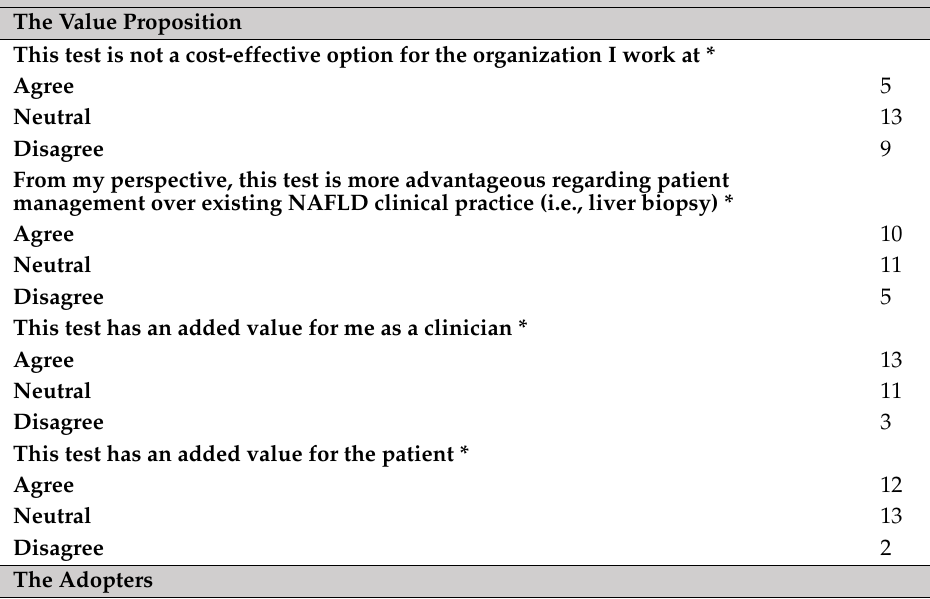
ELF FibroScan PRO-C3 (N = 27) (N = 27) (N =